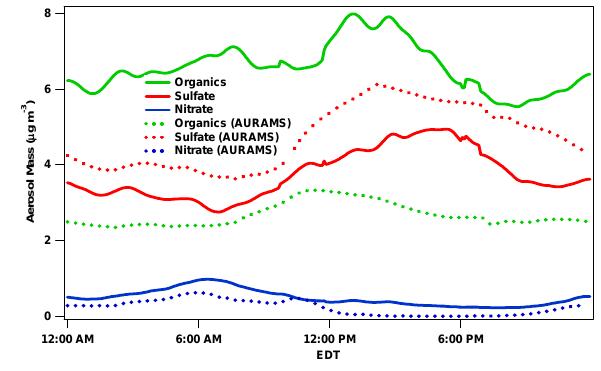
Figure 12. Comparison between diurnal profiles for AMS measurements (solid lines) and Fig. 12. Comparison between diurnal profiles for AMS measure- AURAMS predictions (dotted lines). ments (solid lines) and AURAMS predictions (dotted